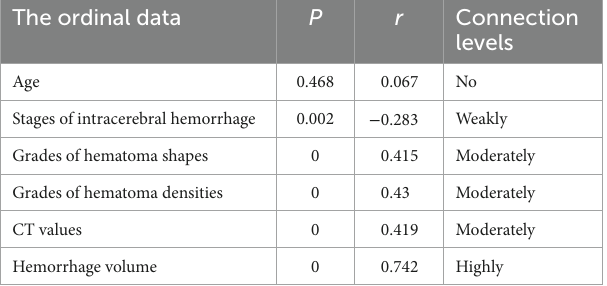
TABLE 2 Correlation between ordinal data and the status of consciousness by Spearman rank correlation test.